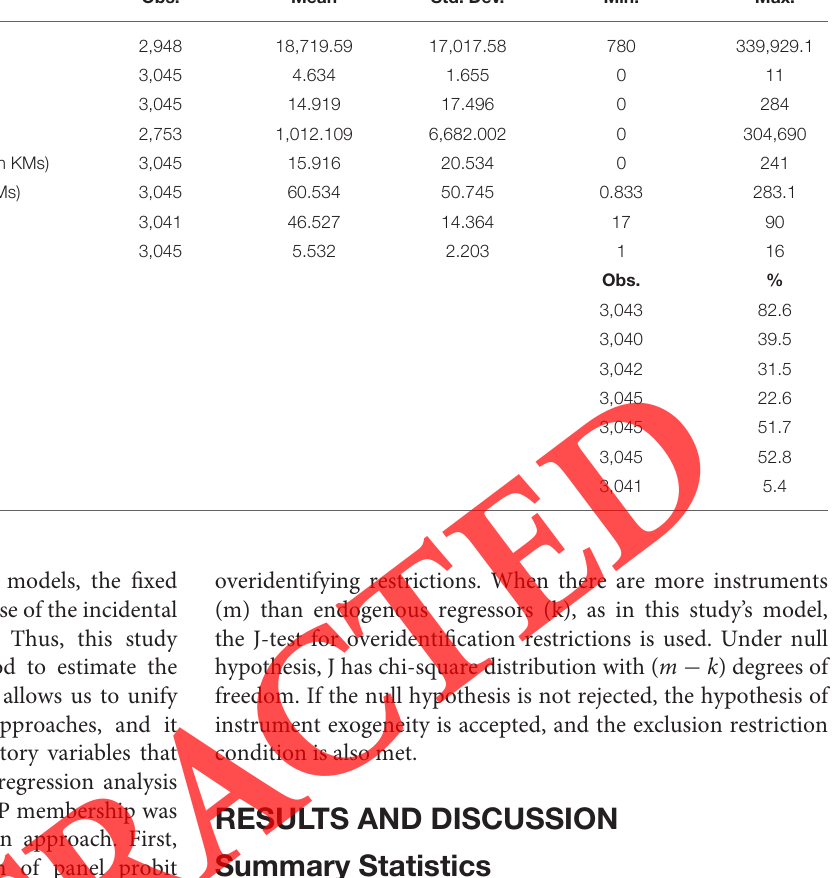
TABLE 1 | Descriptive statistics of the key variables. Continuous variables